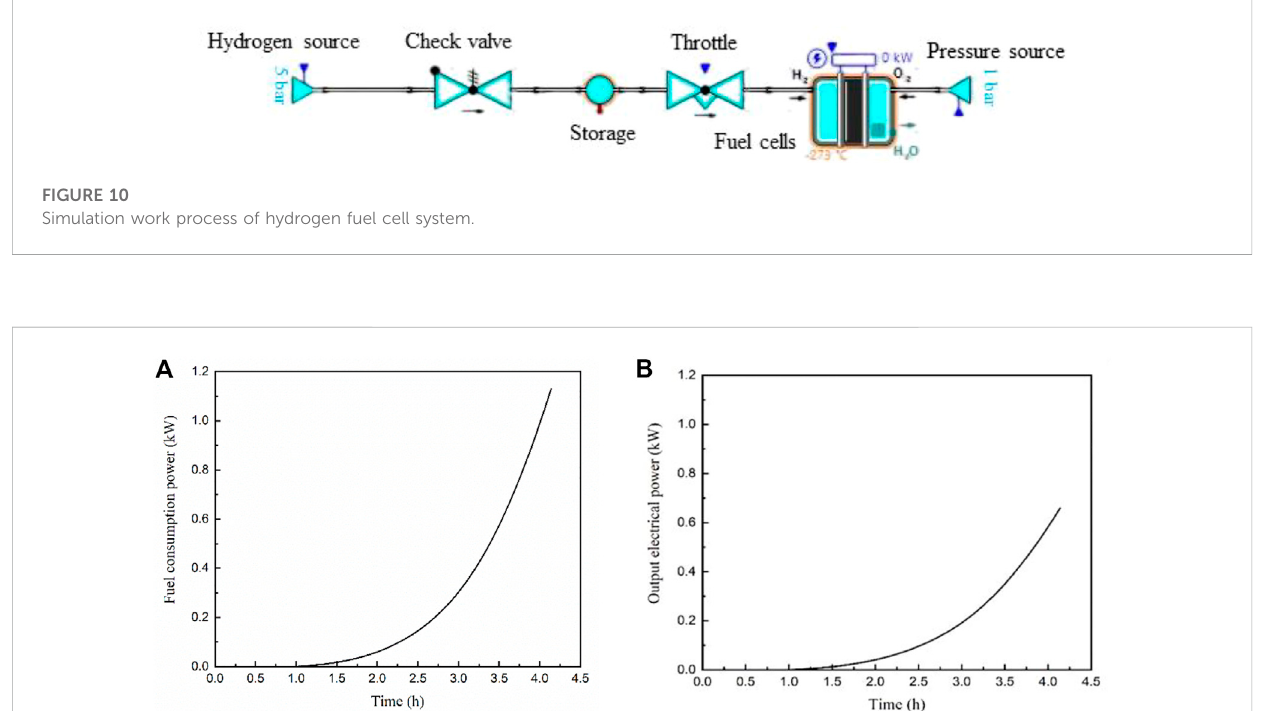
FIGURE 11 Simulation results of a hydrogen fuel cell system with (A) the fuel consumption power change and (B) the output electrical power